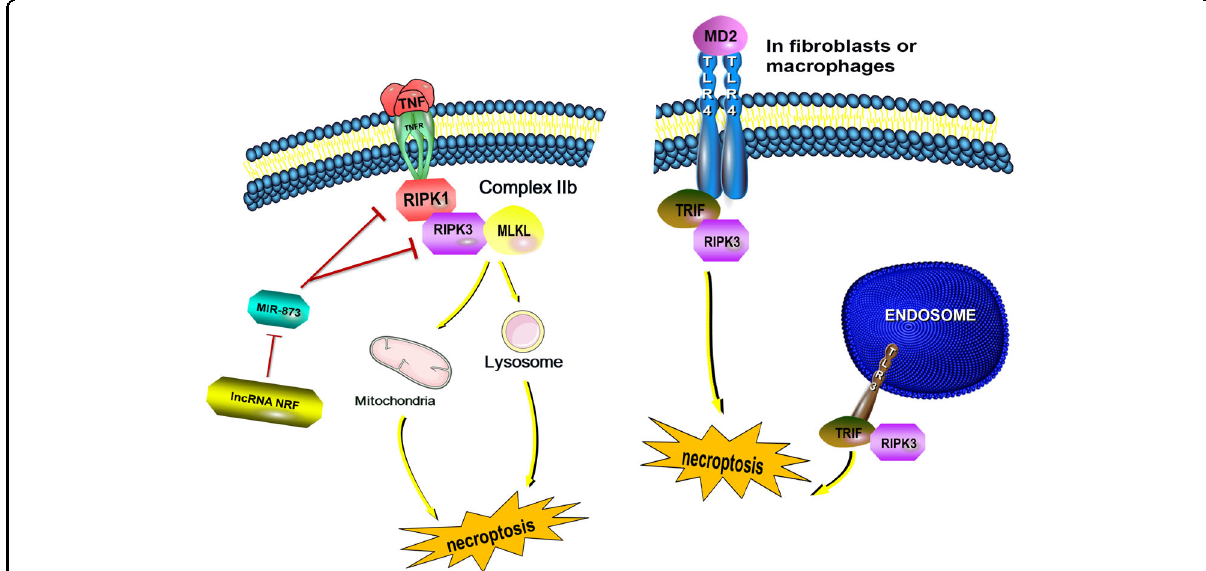
Fig. 3 TNF-induced necroptosis. Necroptosis is a newly-described form of programmed cell death. Activating MLKL plays an important role in this process. The most widely studied subtype involves the TNF-inducible cell signal. In TNF-activated cells, RIPK1 is activated, and then activated RIPK1 forms complex IIb with RIPK3. MLKL is then phosphorylated by RIPK3 and recruited into the necrosome through interaction with RIPK3. By targeting organelles such as mitochondria and/or lysosomes, the cell membrane is destroyed, eventually leading to necrosis by cell lysis. LncRNA can regulate necroptosis by in fl uencing this pathway. For example, the lncRNA NRF can directly downregulate miR-873, thereby reducing RIPK1/RIPK3 inhibition by miR-837, fi nally promoting necroptosis. In fi broblasts and macrophages, TLR3 or TLR4 interacts with RIPK3 through Total Recordable Incident Frequency (TRIF) to directly activate necrosis, independent from the RIPK1 signaling pathway. Cell swelling, mitochondrial dysfunction, membrane permeability, and cytoplasmic content release are